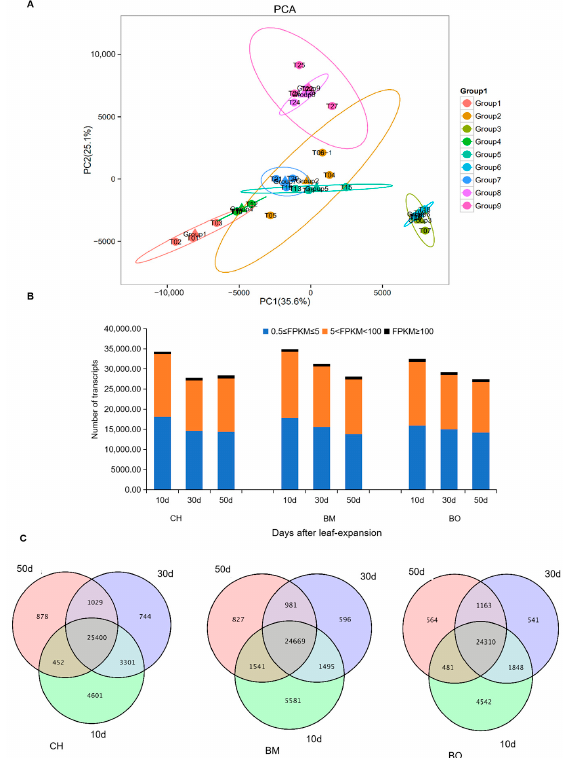
Figure 4 （ Replaced). Characterization of unigene expression.(A) PCA （ The texts in fig4A were generated by software and they should be in a good shape. ） analysis of 27 RNA-seq samples based on unigene transcription levels. The key of the sample code can be found in Table S1. ( B ) Distribution of unigene transcription levels in CH, BM, and BO leaves at di ff erent growth stages. ( C ) Venn diagram showing the overlap of the transcribed unigenes among different growth stages in CH, BM, and BO leaves.